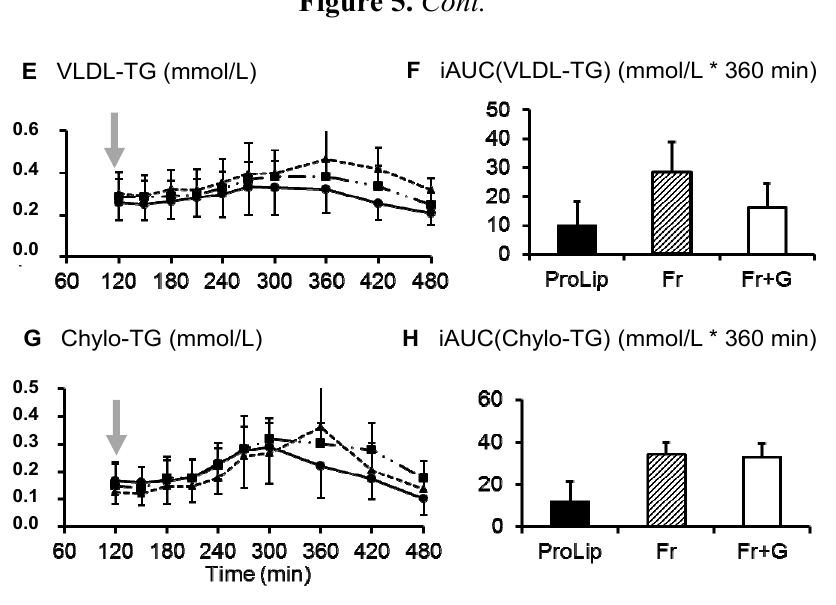
Figure 6. Plasma ApoB48 ( A ), ApoBtot ( B ), 13 C-palmitate-VLDL ( E ), 13 C-palmitate- chylomicrons ( G ) ( n = 8). Additionally, their corresponding iAUC ( B , D , F and H ) ( n = 8). * p < 0.05 vs . ProLip, $ p < 0.05 vs .